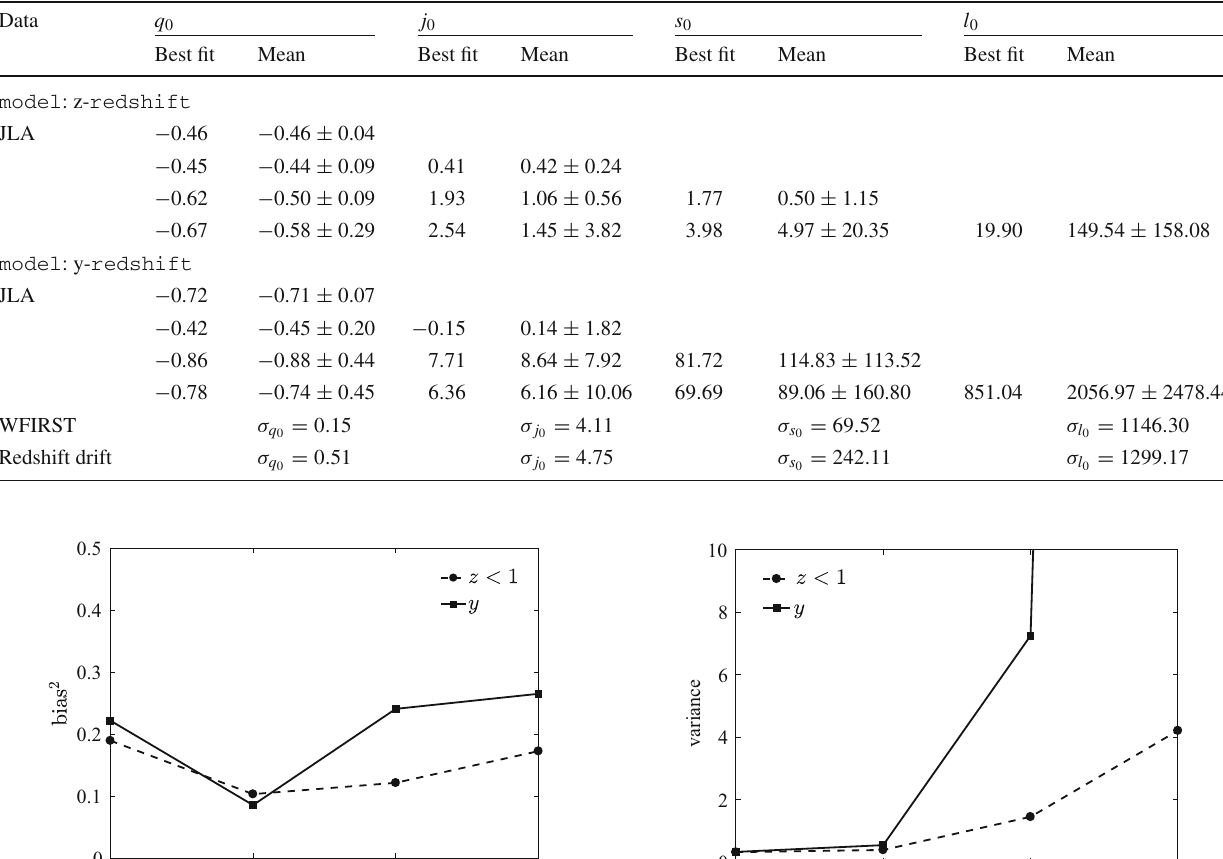
Table 1 Constrained cosmographic parameters by the JLA compilation and mock data within 1 σ confidence level